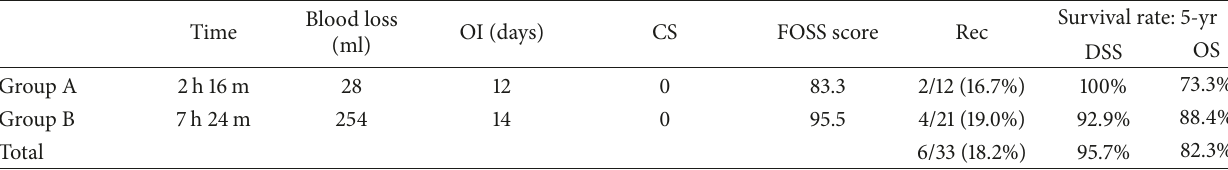
Table 3: Background for surgery and posttreatment function.